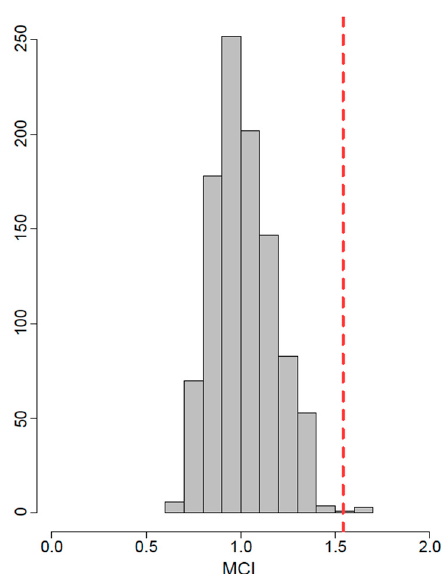
Figure 6. Multidimensional convergence index (MCI) of the sympatric and allopatric populations of both species obtained for the mandible (vertical dotted line) compared with a randomized distribution of MCI values.